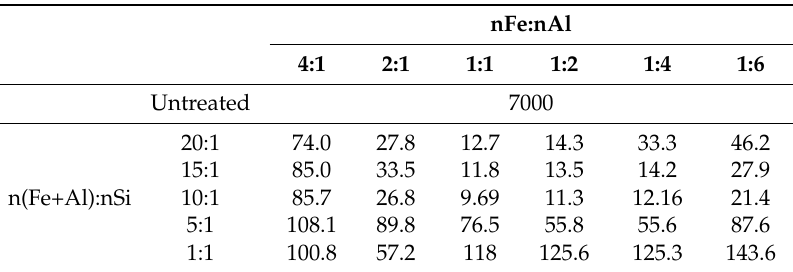
Table 2. n(Al+Fe):nSi and nAl:nFe orthogonal test